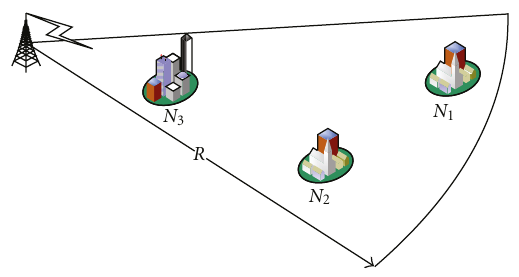
Figure 9: Sector with multiple sets of SSs.